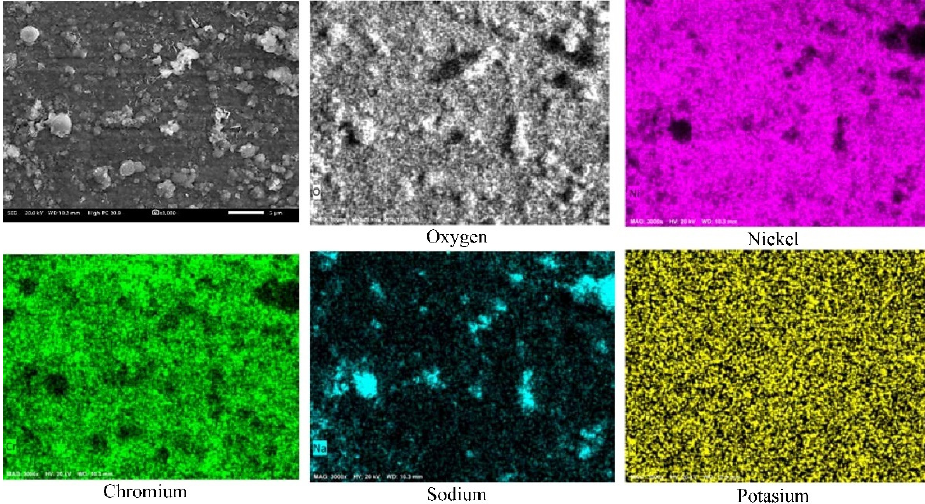
Figure 4. Element mapping of the Ni20Cr alloy surface immersed in Solar Salt at 500 °C and 1000 h of immersion.